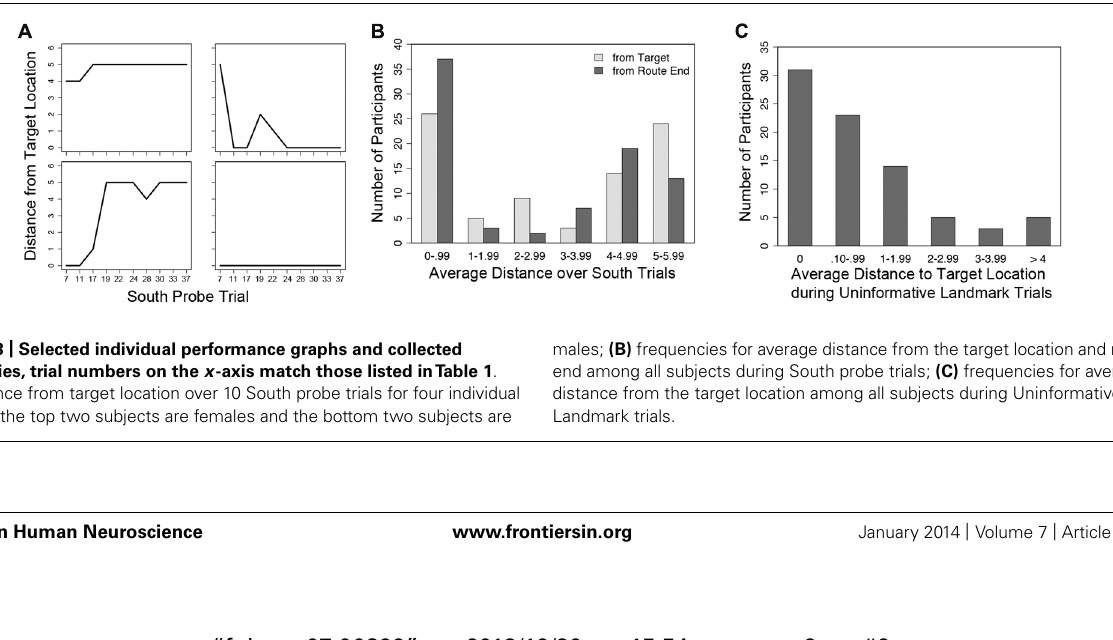
FIGURE 3 | Selected individual performance graphs and collected frequencies, trial numbers on the x -axis match those listed inTable 1 . (A) Distance from target location over 10 South probe trials for four individual subjects, the top two subjects are females and the bottom two subjects are